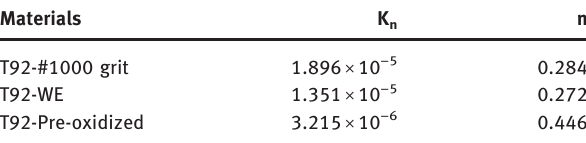
Figure 4. The disappearance of internal oxidation layer may be closely related to the thick oxides. Cross-section morphologies of T92 steel with #1000 grit finish after different times were displayed in Figure 5.